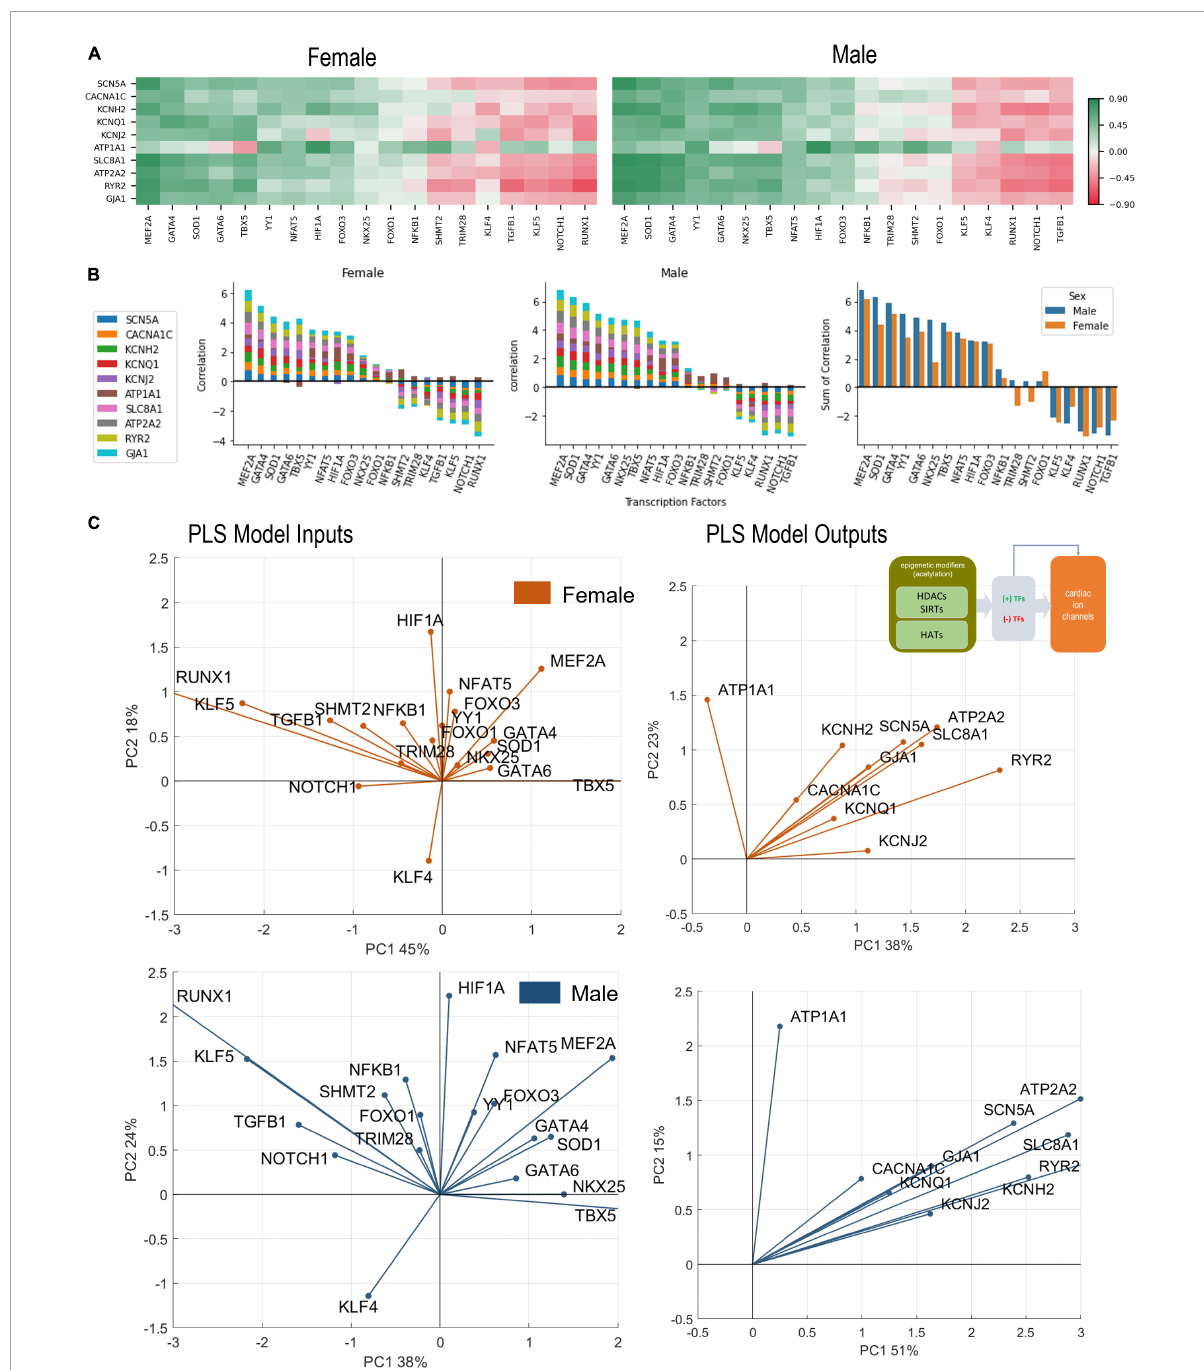
FIGURE4 Analysis of links between cardiac TFs and key cardiac ion channels. (A) Pearson’s correlation of key ion channels with cardiac TFs for female (left) and male (right) LV heart samples. The ranking of the TFs is done based on sum of correlations (from predominantly positive to predominantly negative) from left to right. These ranking yields slightly different order for female and male samples. (B) Bar plots show the cumulative correlation of individual ion channels with each TF for female, male samples, and the final plot shows the overlaid impacts of TFs on ion channels for female and male samples to reveal any differences. (C) PLS regression models trained with the TFs predicting ion channels for female (orange) and male (blue) samples. Inset in B shows the models being investigated. Shown are biplots for the PLS models—constructed as described in Figure 2